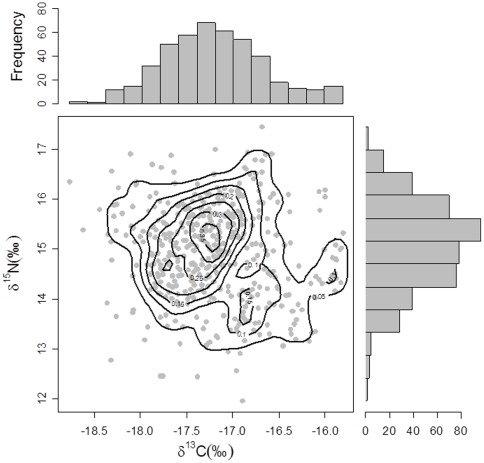
The δ13C and δ15N values for each of the 451 whisker segments from bearded seal pups, grown pre-partum.The marginal frequency distributions for each isotope, and in the main body of the plot, the kernel density contours are also shown.